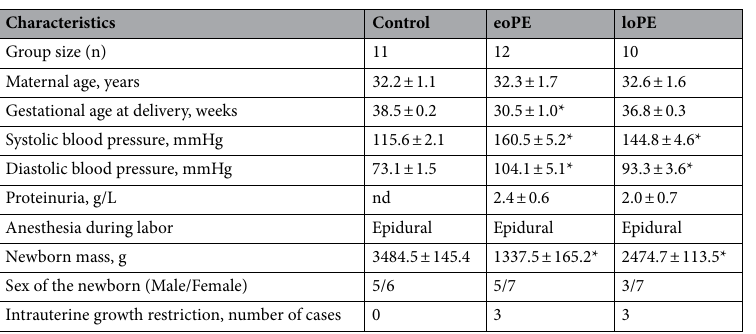
Table 1. Demographic and clinical characteristics of the patients. The data are listed as mean ± SEM; *p < 0.01 vs control; nd not